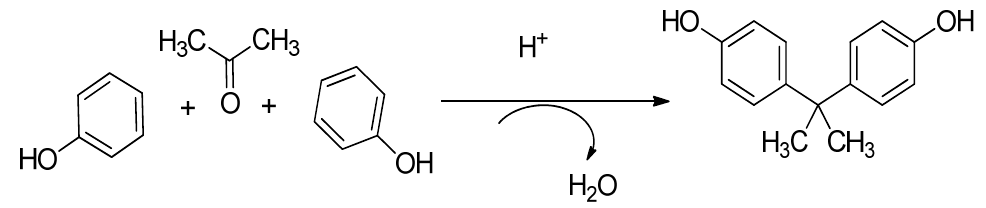
Figure 10. Synthesis and chemical structure of bisphenol A.